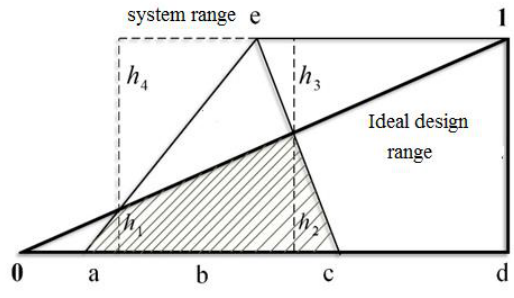
Figure 6. Ideal design range and system